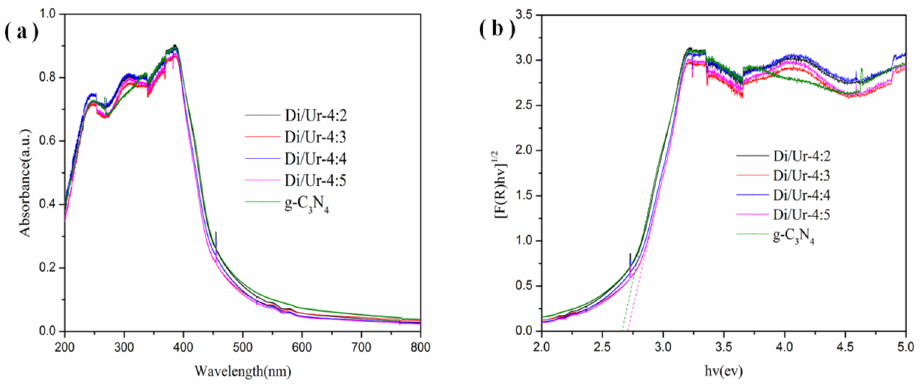
Figure 7. UV-Vis DRS ( a ), and band gaps ( b ), of g-C 3 N 4 and the as-prepared Di/Ur